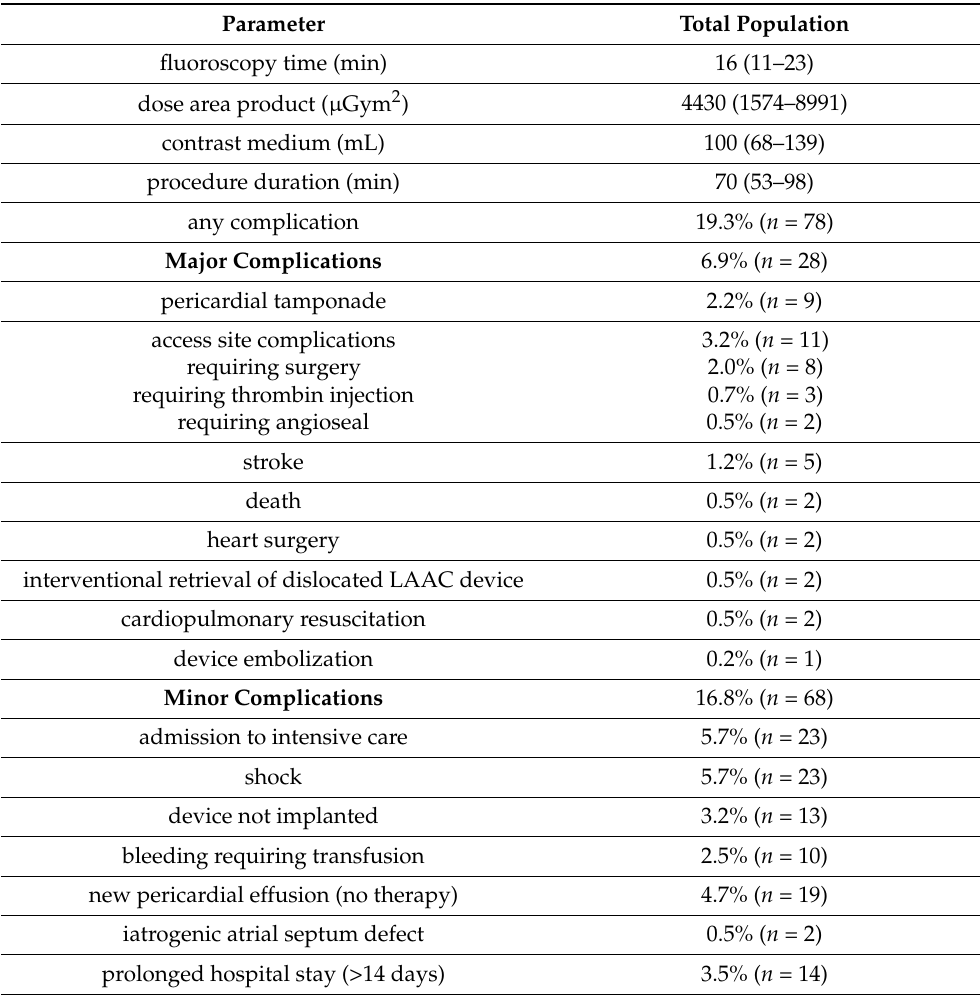
Table 2. Procedural